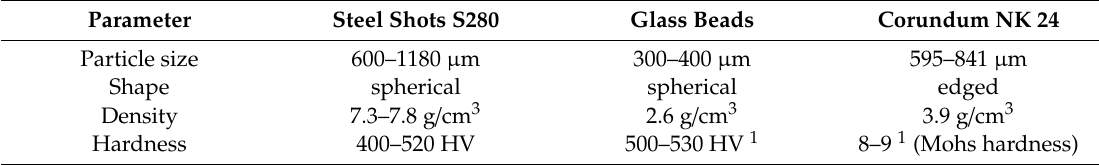
Table 2. Peening media